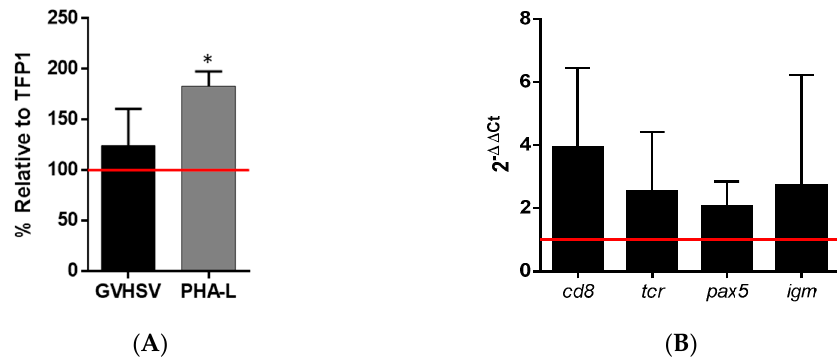
Figure 6. The white blood cell (WBC) proliferation after coculture with GVHSV-transfected RBCs. RBCs and WBCs were purified from the peripheral blood of rainbow trout. WBCs were cocultured with autologous TFP1-transfected RBCs (control), RBCs and PHA-L (positive control), or GVHSV-transfected RBCs. ( A ) WBC proliferation was measured after 7 days as a percentage of fluorescent nuclei (Hoechst stain) using the IN Cell Analyzer and calculated using the following formula: ((number of cell nuclei in WBCs and treated RBCs − number of cell nuclei in untreated RBCs) ÷ (the number of cell nuclei in WBCs and control RBCs – number of cell nuclei in untreated RBCs)) × 100. Data are displayed as mean ± SD ( n = 4). Data are shown relative to the TFP1 condition (control, red line). A Kruskal–Wallis with Dunn’s multiple comparisons test was performed between each condition and the control. * p -value < 0.05). ( B ) WBC gene expression of lymphocyte cell markers was measured at 7 days in cocultures of WBCs and GVHSV- or TFP1-transfected RBCs. Gene expression was evaluated by RT-qPCR. Data are displayed as mean ± SD ( n = 4). The ef1 α gene was used as an endogenous control. Data shown are relative to the TFP1 condition (control, red line). A Wilcoxon test was performed to compare coculture of WBCs and GVHSV-transfected RBCs with WBCs and TFP1-transfected RBCs.